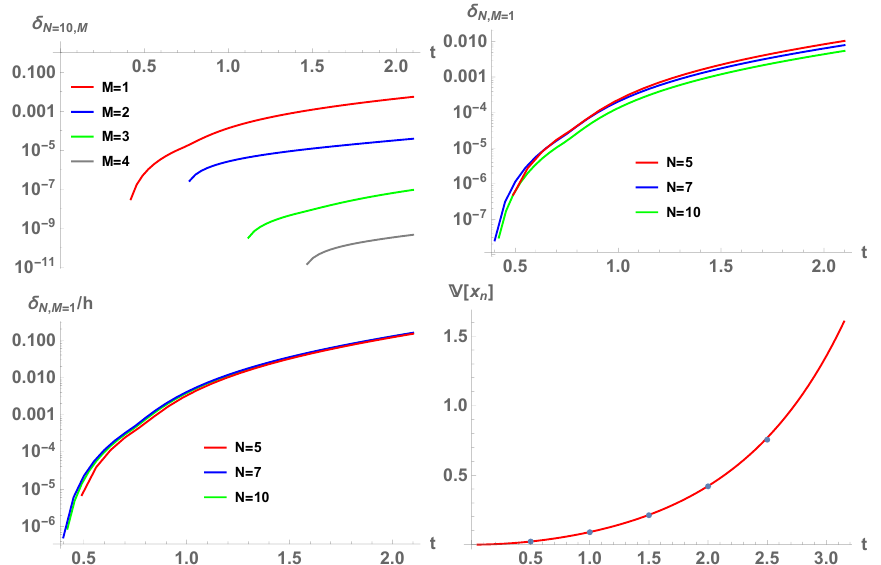
Figure 4. Upper left panel: Absolute errors (log-scale) in the approximation of the variance with the NSFD scheme, with M = 1,2,3,4 and N = 10 ( h = τ / N ). Upper right panel: Absolute errors (log-scale) in the approximation of the variance with the NSFD scheme, with N = 5,7,10 ( h = τ / N ) and M = 1. Lower left panel: Errors from the upper right panel divided by h . Lower right panel: Approximation of the variance with the NSFD scheme, with M = 1 and N = 7, and comparison with Monte Carlo simulation (circles) using 10,000 realizations. This figure corresponds to Example